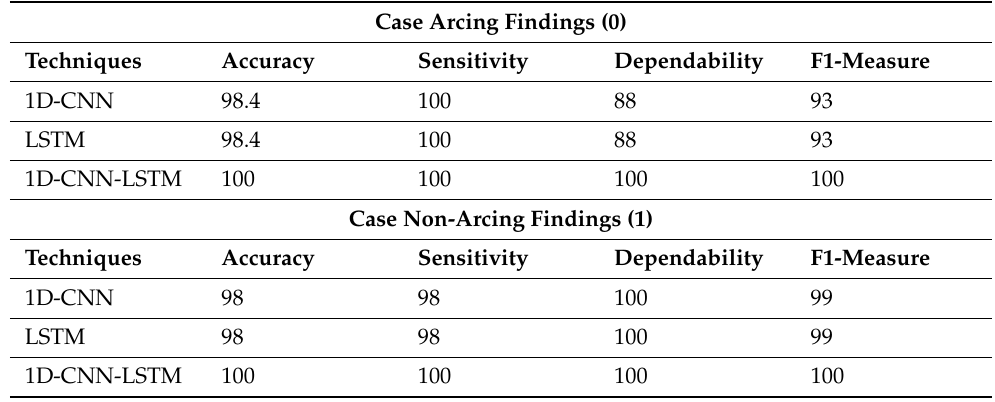
Table 11. The assessment of metrics in accordance with the performance outcomes of DL Structure during testing for the time domain in cases of arcing and non-arcing.